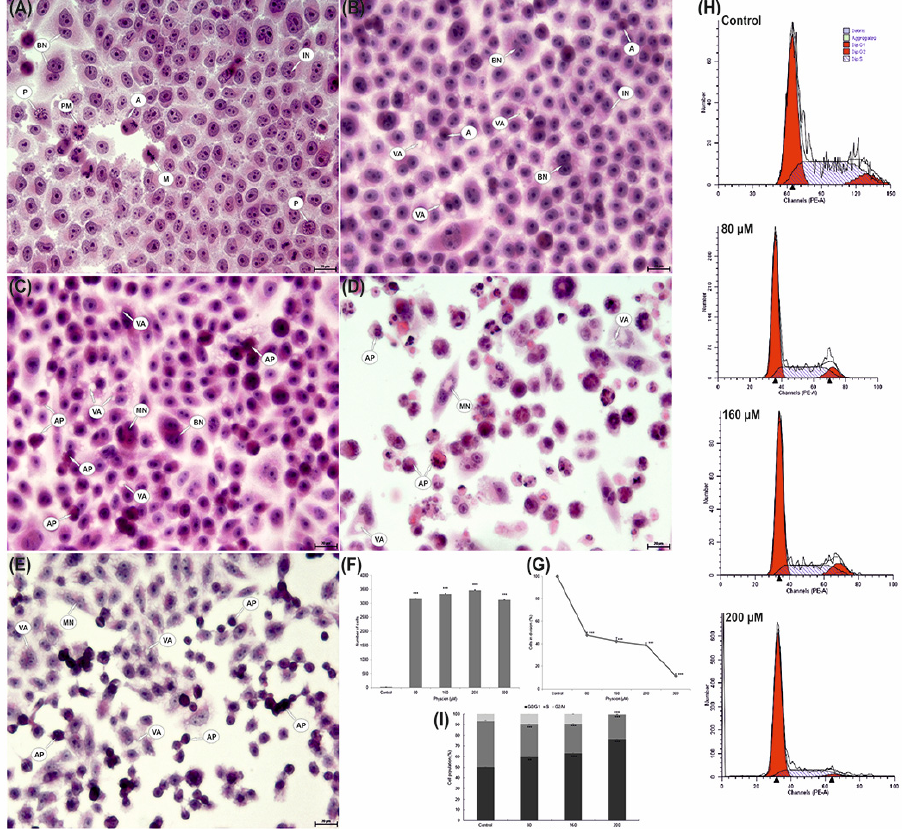
Figure 6. Morphological changes in HeLa cells after 48 h of exposure to physcion. ( A ) Control cells with normal morphol- ogy and numerous cells in division. ( B ) Cells with vacuoles present in the cytoplasm (80 μ M). Numerous cells with strong cytoplasmic vacuolization covering the entire cell area and numerous apoptotic cells ( C —160 μ M, D —200 μ M and E —300 μ M). IN—interphase, P—prophase, PM—prometaphase, M—metaphase, A—anaphase, AP—apoptotic cells, VA—cells with cytoplasmic vacuolization, BN—binuclear cells, MN—multinucleated cells. Hematoxylin and eosin staining. Magni- fication, ×4000. ( F ) Number of cells with cytoplasm vacuolization. ( G ) Mitotic index of HeLa cells. Data correspond to mean values ± S.E. from three different experiments. The differences were confirmed statistically at: *** p < 0.001. ( H ) Effect of physcion at concentrations (80 μ M, 160 μ M and 200 μ M) on cell cycle progression in HeLa cell lines. ( I ) Percentage of cells in different phases of the cell cycle. Cell cycle distribution was analyzed by flow cytometry. Data correspond to mean values ± S.E. from three different experiments. The differences were confirmed statistically at: *** p < 0.001.